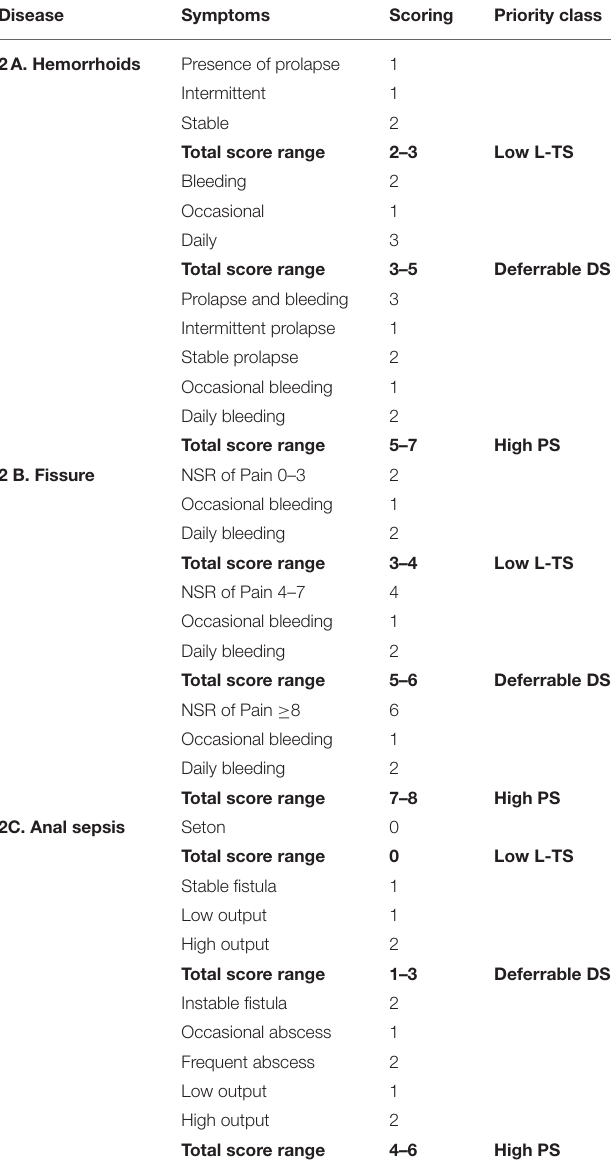
TABLE 2 | Construction of a severity score based on symptoms severity and frequency. Disease